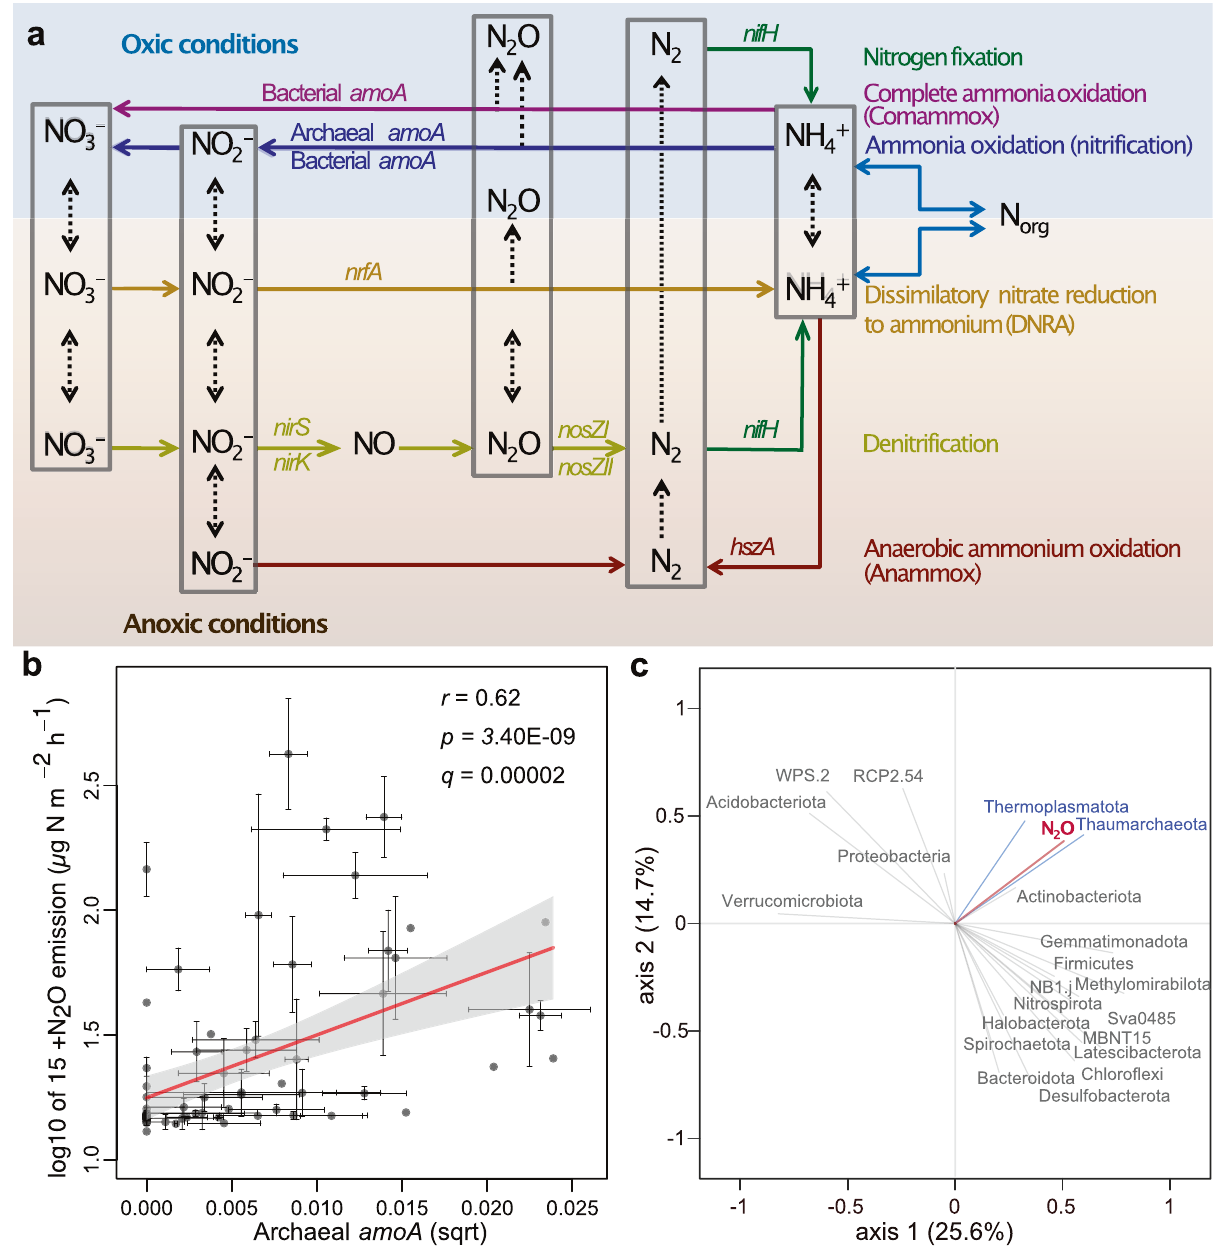
Fig. 3 Archaea and archaeal amoA strongly correlate with N 2 O across global wetland soils. a Schematic view of nitrogen cycle in soils and the key genes involved. b Relationship between site mean relative abundance of archaeal amoA and N 2 O emission ( n = 74 independent sites). The relative abundance of archaeal amoA was determined based on the relative abundance of metagenomics reads assigned to ENOG411114F (extracted from Hellinger transformed abundance matrix of archaeal OGs). The inset numbers represent a Spearman rank correlation coef fi cient ( r ) and corrected p -value for multiple testing using Benjamini – Hochberg method ( q ). Error bars represent the standard errors (SE) of the site means. c Partial least-squares regression (PLS regression) plot showing the relationships among the relative abundances of prokaryotic taxonomic groups (as determined by 16S metabarcoding) and N 2 O emission ( n = 74 independent sites). Blue lines represent archaeal phyla. The statistical test used was